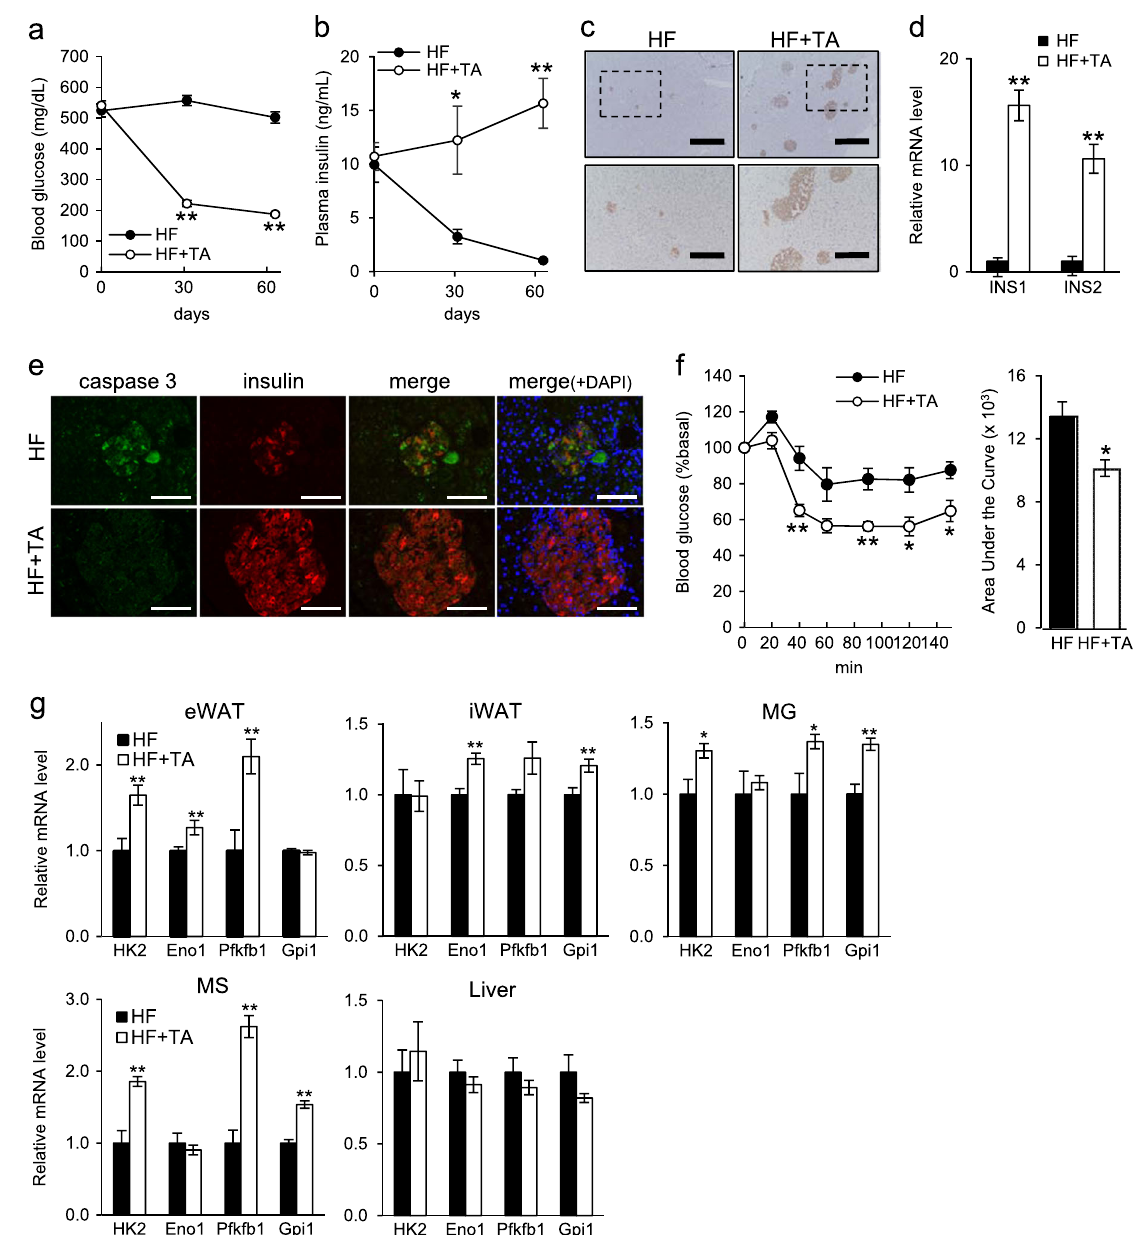
Fig. 2 Protective effect of TA-1887 on pancreas and insulin sensitivity in db/db mice fed a high-fat (HF) diet. a , b Blood glucose and plasma insulin ( n = 8) levels at 0, 1, and 2 months of indicated treatments. c Image showing insulin immunostaining in pancreatic tissue of representative mice after 4 months of indicated treatment. Squares in upper panels are magni fi ed in corresponding lower panels. Scale bars: 500 μ m (upper), 200 μ m (lower). d Analysis of INS1 and INS2 mRNA expression in mouse pancreatic tissue after 4 months of treatment ( n = 5 – 9). e Representative double immunostaining of insulin and active caspase 3 in pancreatic tissue after 4 months of treatment. Scale bars: 100 μ m. f Insulin tolerance test after 10 weeks of drug treatment and corresponding AUC ( n = 5 – 9). g levels of mRNAs encoding glycolytic enzymes ( n = 5 – 9) in eWAT, iWAT, MG, MS and liver after 4 months of treatment. DAPI, 4',6-diamidino-2-phenylindole; INS1, insulin I; INS2, insulin II; HK2, hexokinase 2; Eno1, enolase 1; PFKFB1, 6-phosphofructo-2-kinase/fructose-2,6-biphosphatase 1; Gpi1, glucose phosphate isomerase 1. Values shown are means ± SEM. * p < 0.05 and ** p < 0.01 versus